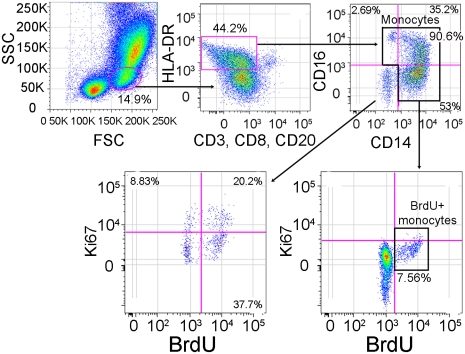
Gating strategy for identifying BrdU+ monocytes.In order to identify BrdU+ monocytes after in vivo BrdU injection, we used flow cytometry on whole blood. We first gated on the monocytes based on their forward (FSC) vs. side scatter (SSC) properties (far left panel), then excluded HLA-DR negative cells as well as T-lymphocytes using anti-CD3, NK cells using anti-CD8 and B-lymphocytes using anti-CD20 (second panel from left). Next, we examined monocytes based on their expression of CD14 and CD16 (right top panel). We examined the expression of Ki-67 and BrdU on monocytes (including CD14+CD16−, CD14+CD16+ and CD14−CD16+) (bottom right panel). For the purpose of this study, CD14−CD16− cells were excluded from all further analyses since this population contains CD34+ hematopoietic stem cells and dendritic cells (bottom left panel). This gating and data are representative of an infected rapid progressor at day 27 post-infection out of all animals studied.